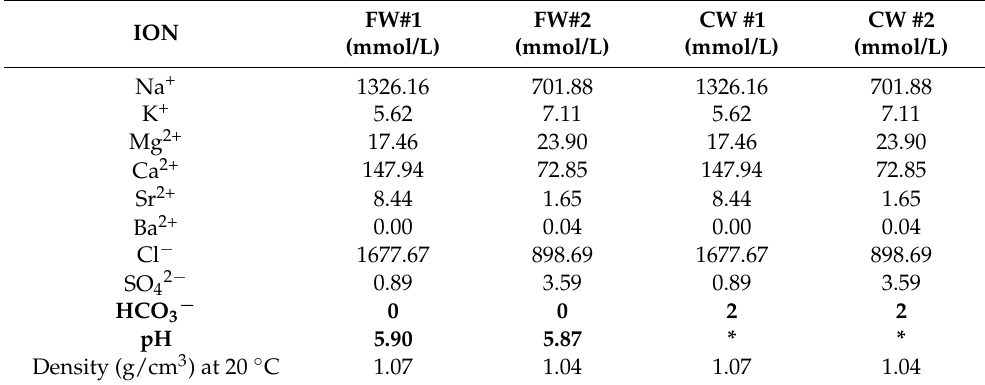
Table 3. Ionic compositions of used brines.